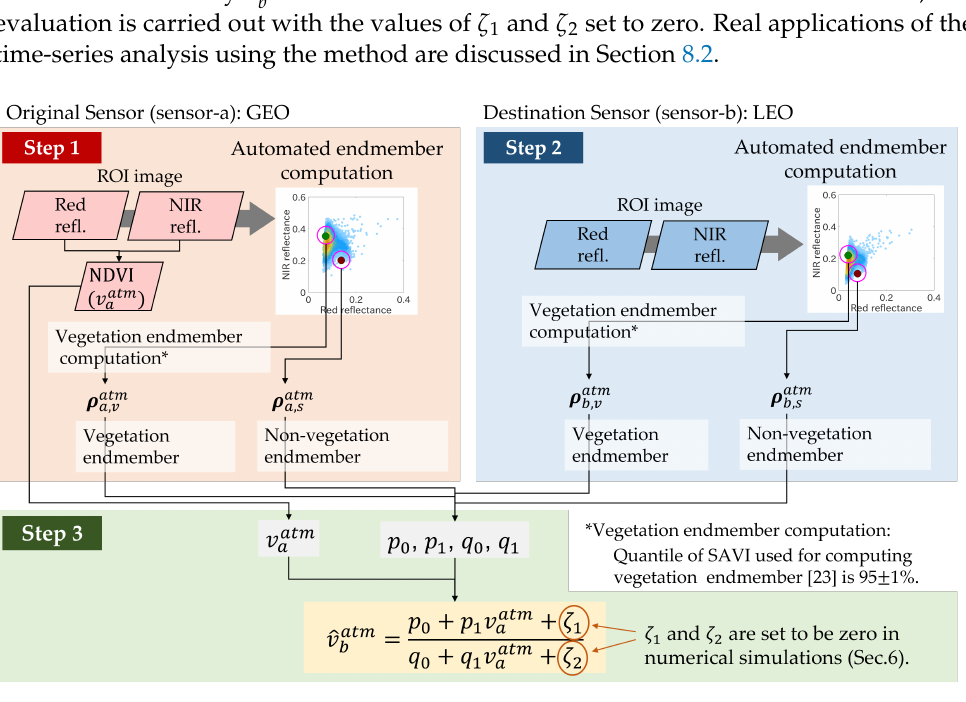
Figure 3. Schematic of a basic algorithm for the NDVI transformation